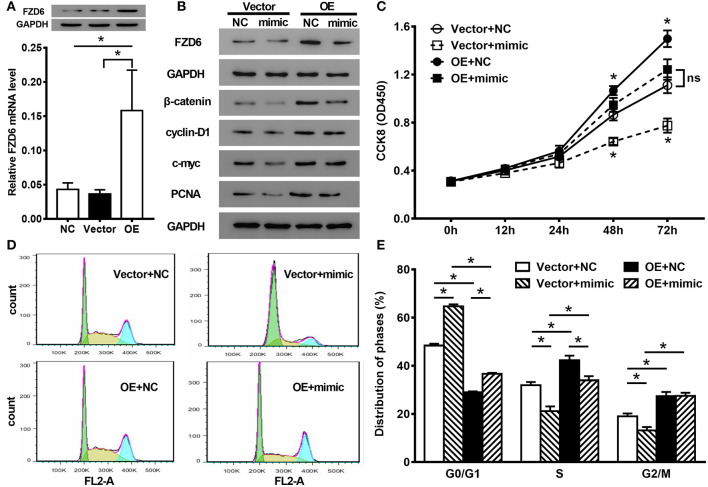
The rescue experiments of cell proliferation and cell cycle distribution. (A) The mRNA and protein expression of FZD6 in U87 cells modulated by the overexpression of FZD6 (OE) and control vectors (Vector). (B) The protein expression in U87 cells of FZD6 and proliferation-related biomarkers in the miR-935 mimics together with or without the overexpression of FZD6. (C) The cell proliferation was analyzed by the CCK8 assay, and the proliferated depression induced by miR-935 (open square, Vector + mimic) was alleviated by the co-overexpression of FZD6 (closed square, OE + mimic). While the overexpression of FZD6 enhanced the proliferation of U87 cells (closed circle, OE + NC). (D,E) The effect on the cell circle distribution of the miR-935 mimic treatment, together with or without FZD6 overexpression; *p < 0.05 at indicated time points or between the indicated groups, the one-way ANOVA followed by the Bonferroni test.